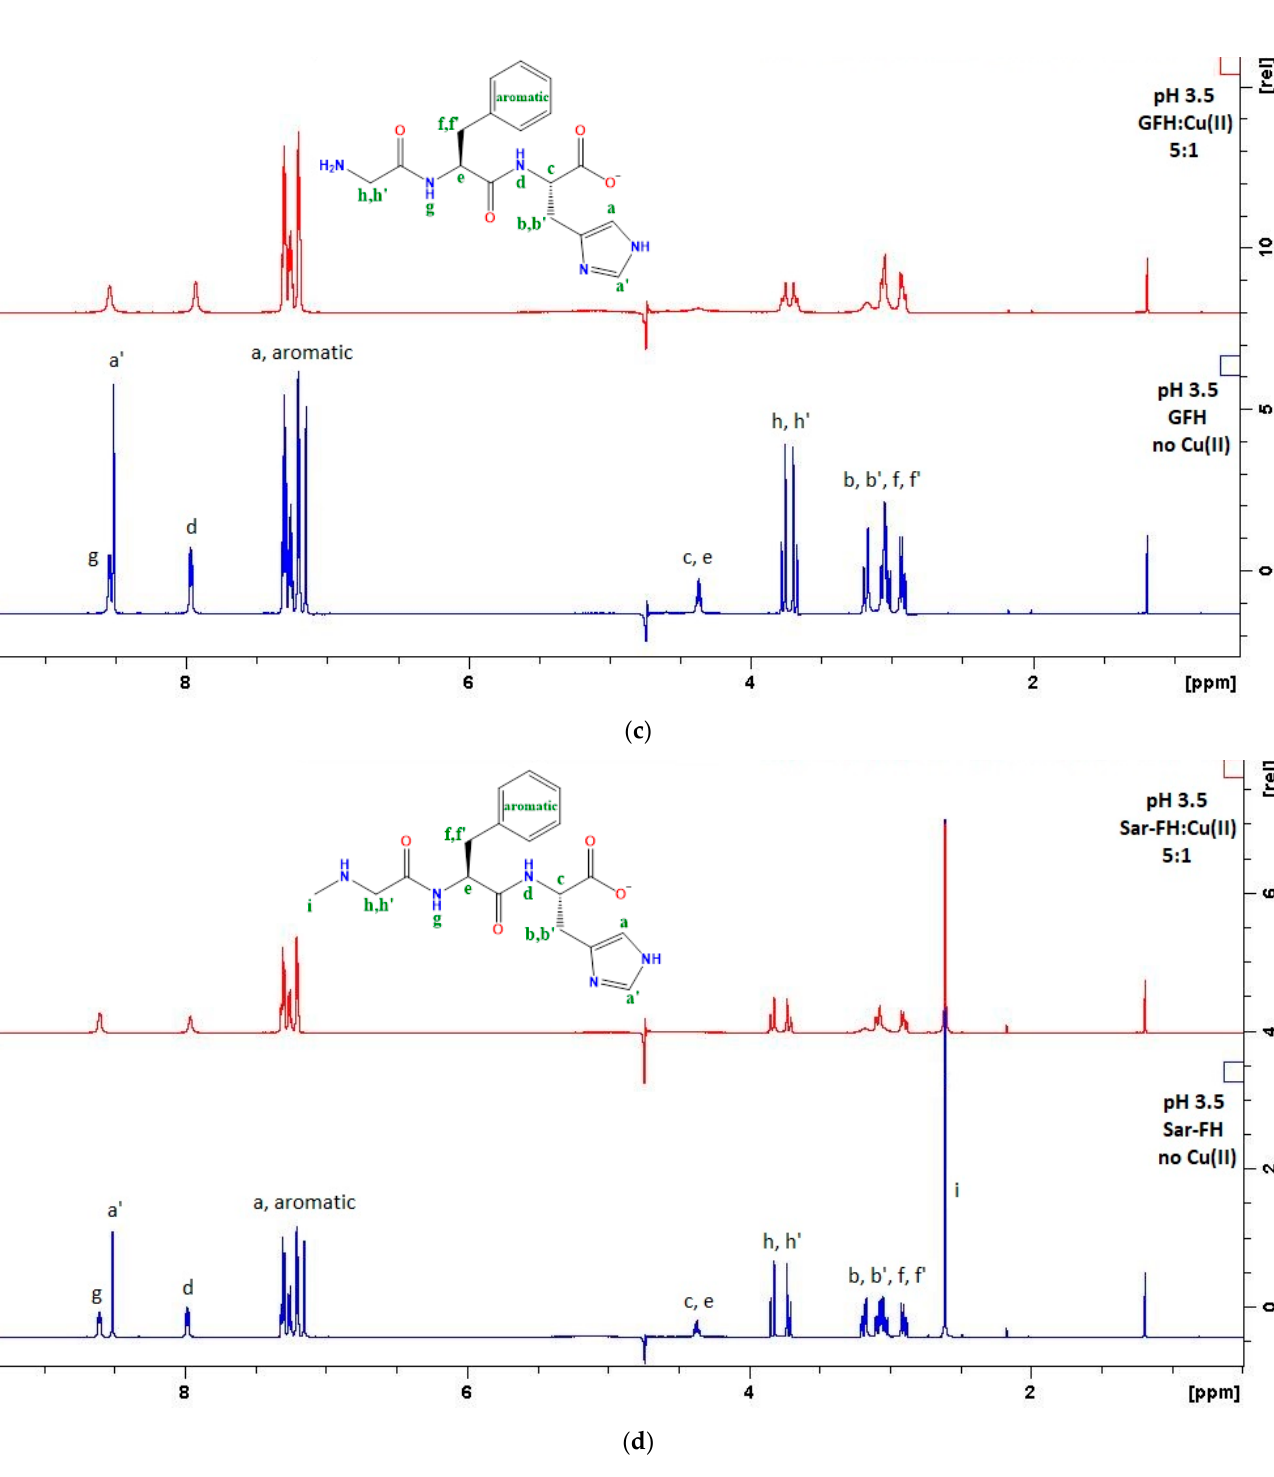
Figure 10. The 1 H NMR spectra (blue) of the ligand ( a ) GLH, ( b ) Sar-LH, ( c ) GFH and ( d ) Sar-FH and the 1 H NMR spectra (red) after ( a ) GLH, ( b ) Sar-LH, ( c ) GFH and ( d ) Sar-FH had been titrated with copper(II) to reach a 5:1 ligand:copper(II) ratio at a pH of 3.5 in 90% water and 10% D 2 O.